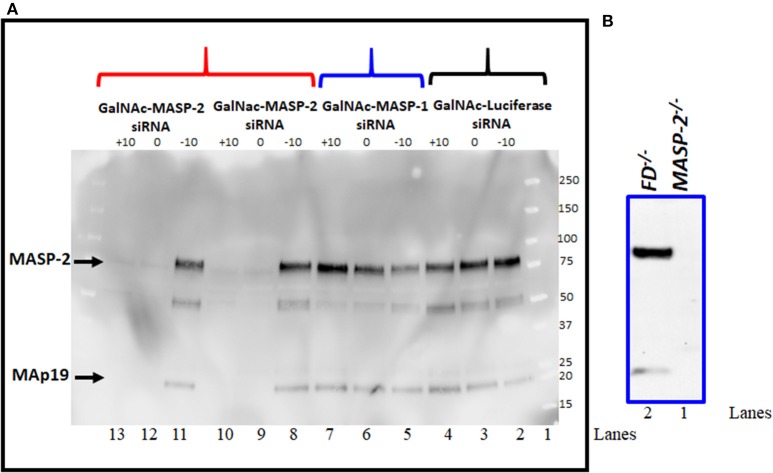
(A) Western blot analysis showing nearly complete elimination of MASP-2 in the circulation of WT arthritic mice treated with GalNAc-MASP-2-siRNA. MASP-2 protein from arthritis mice before (day –day 10) and after treatment and before disease induction (day 0) and after disease induction (day +10) was pulled out by using D-Mannose-Agarose beads as mentioned in the Materials and Methods. The primary detection antibody biotinylated Rat anti-human MASP-2/MAp19 (6G12) and secondary antibody HRP-conjugated Streptavidin were used, respectively. Complete absence of MASP-2 (~75 kDa) in the circulation of WT mice treated with GalNAc-MASP-2-siRNA at day 0 and at day +10 (lanes 12, 13). Presence of MASP-2 prior to the treatment with GalNAc-MASP-2 and prior to the disease induction (lane 11). Repeat data from another mouse treated identically with GalNAc-MASP-2-siRNA (lanes 8, 9, and 10). Presence of MASP-2 in the circulation of mice treated with GalNAc-MASP-1-siRNA at day −10, at 0 and at +10 (lanes 5, 6, and 7). Presence of MASP-2 in the circulation of mice treated identically with control GalNAc-Luciferase-siRNA at day −10, at 0 and at +10 (lanes 2, 3, and 4). Lane 1 (protein marker). A band of MAp19 (a.k.a. sMAP) (19 kDa) was also seen in the sera from mice (lanes 2–8 and 11). Sera from MASP-2−/− and FD−/− mice with no disease were used a negative and positive controls, respectively (B lanes 1 and 2). Representative data from GalNAc-Luciferase-siRNA (n = 1) or GalNAc-MASP-1-siRNA (n = 1) or GalNAc-MASP-2-siRNA (n =2) treated mice have been shown. Western blot were repeated 2x with identical results.